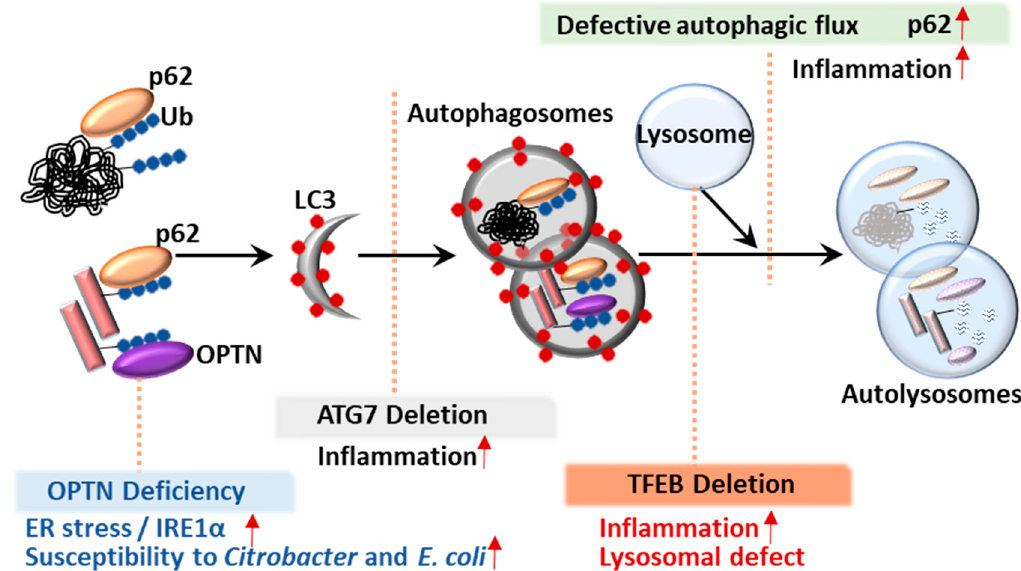
Figure 2. The process of autophagy flux and involved genes. The autophagy flux is depicted. A normal autophagic flux includes the autophagosome formation and maturation step and the autolysosome formation step. The possible conditions associated with involved genes are depicted: (1) OPTN deficiency leads to an accumulation of IRE1 α and increased susceptibility of Citrobacter and E. coli . (2) ATG7 deletion is associated with increased inflammation. (3) TFEB deletion results in increased inflammation and lysosomal defect.